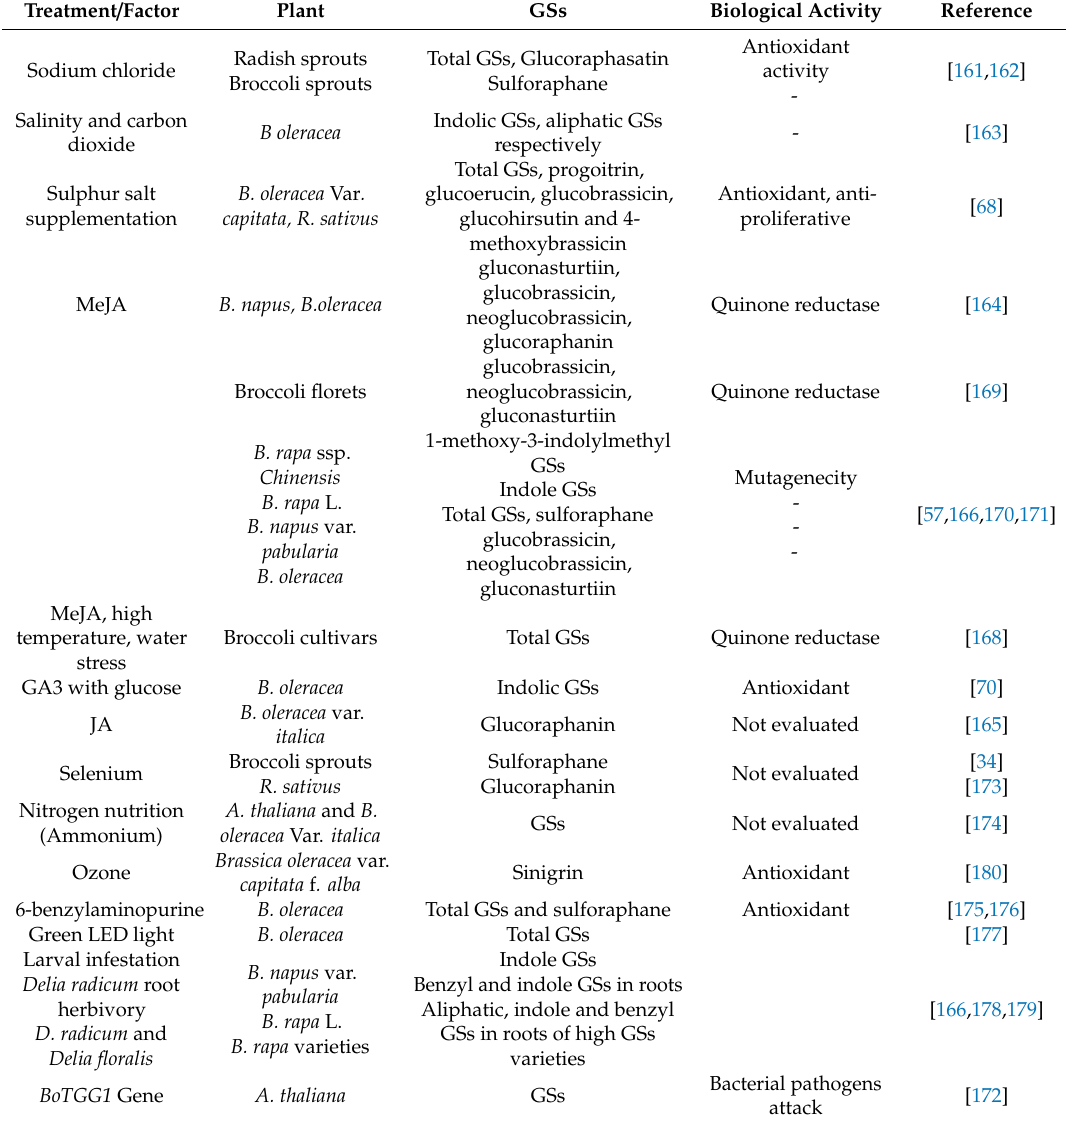
Table 3. Improving GSs / GSHPs and bioactivity in plant.